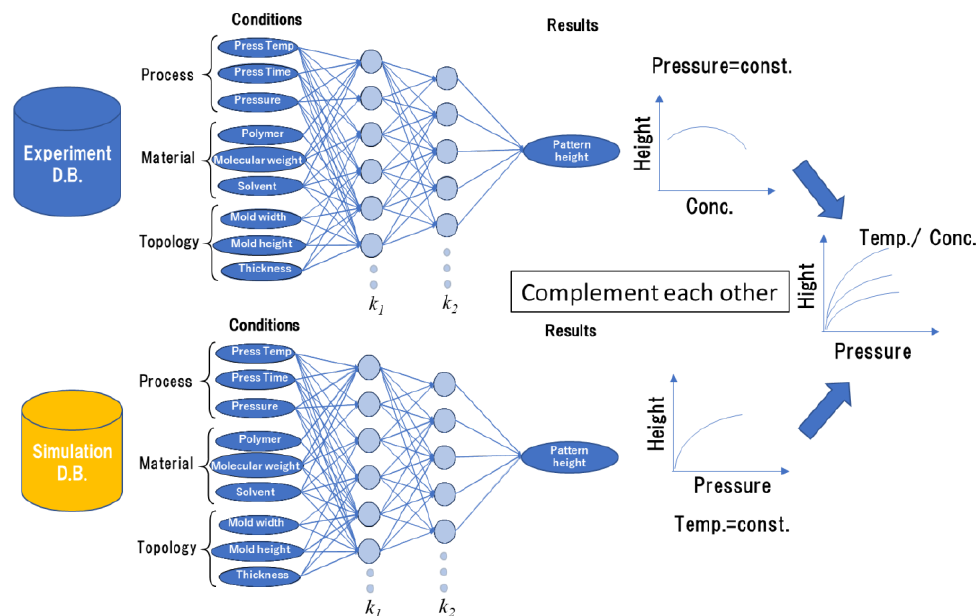
Figure 2. Schematics of a ‘hybrid’ deep learning system in combination with experiment and simulation.